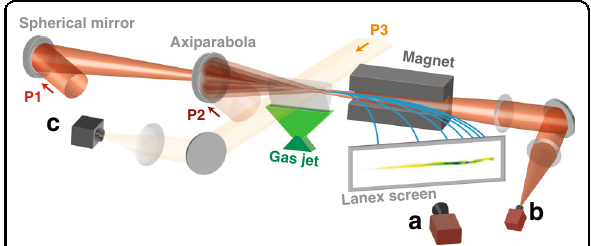
Fig. 1 Schematic view of the experiment and main diagnostics. The laser is split into three separate beams: P1 - the acceleration driver, P2 - the pulse that generates the waveguide, and P3 - the probe beam. The two main beams, P1 and P2, are focused in a 15 mm long rectangular gas jet. The generation beam, P2, is focused in the target, 2 ns before P1, by an f/4 axiparabola. The main beam, P1, is focused by an f/18 spherical mirror. It accelerates electron bunches whose energy is then analyzed with a spectrometer consisting of a dipole magnet, a LANEX scintillating screen and a 16 bits camera a . It is eventually attenuated to image its focal spot after interaction ( b ). The probe beam, P3, crosses the plasma transversely, just after P1 ( c ). It is then sent to a wavefront sensor to measure the transverse density pro fi le